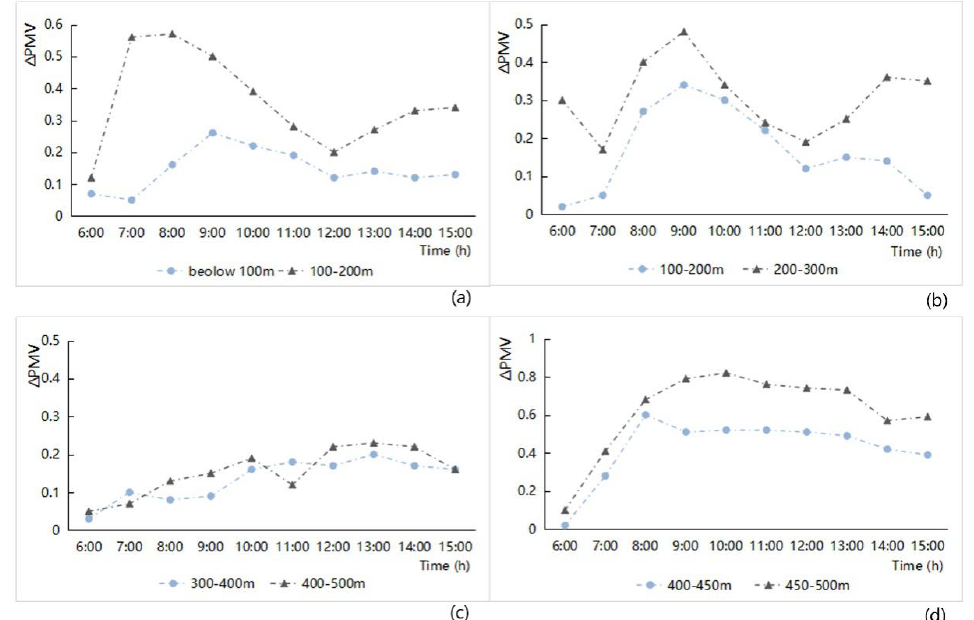
Figure 12. Hourly ΔPMV variation analysis related to different grade junction spacings of the street network from 6:00 to 15:00 in the four study areas (( a ) Old downtown; ( b ) Gubei international community; ( c ) Anting New Town; ( d ) New Jiangwan Town).